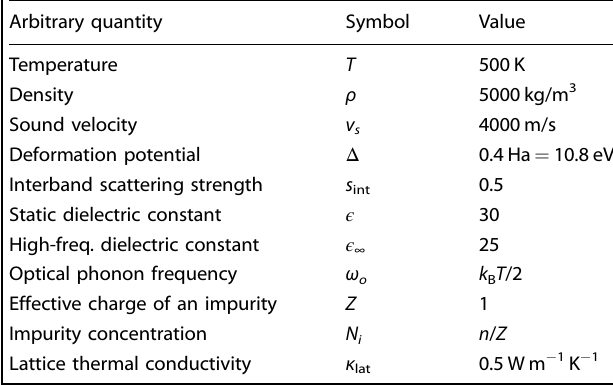
Table 1. Arbitrary quantities used in the scattering and transport